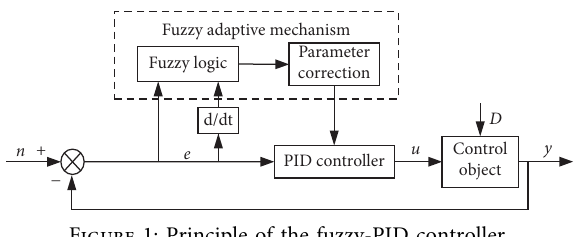
Figure 1: Principle of the fuzzy-PID controller.